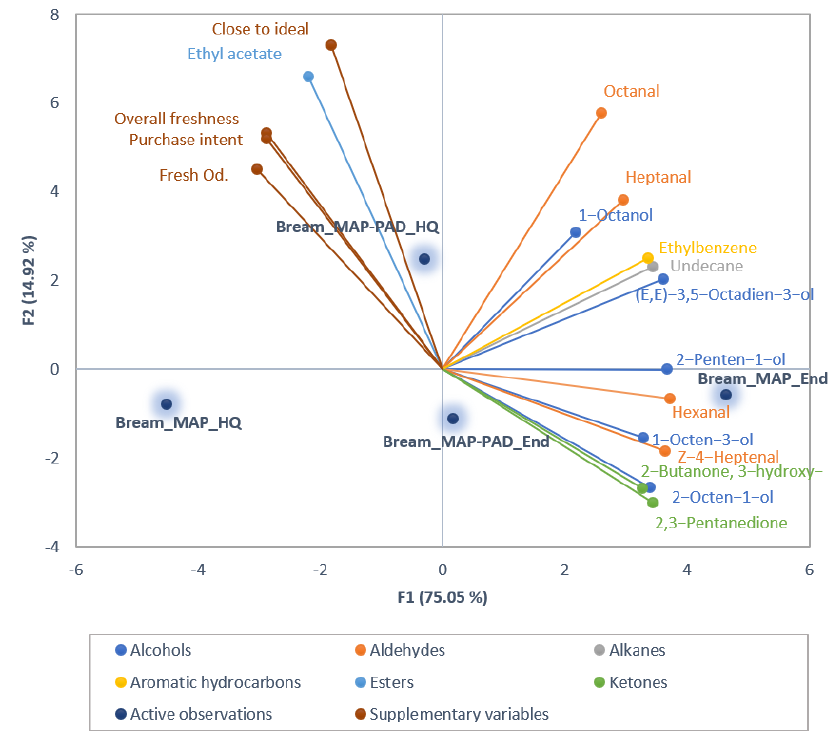
Figure 2. Principal component analysis (PCA) biplot of volatile compounds that differed significantly or showed a tendency for difference ( p < 0.1) among the seabream fillets, with consumer perceived freshness attributes presented as supplementary data.